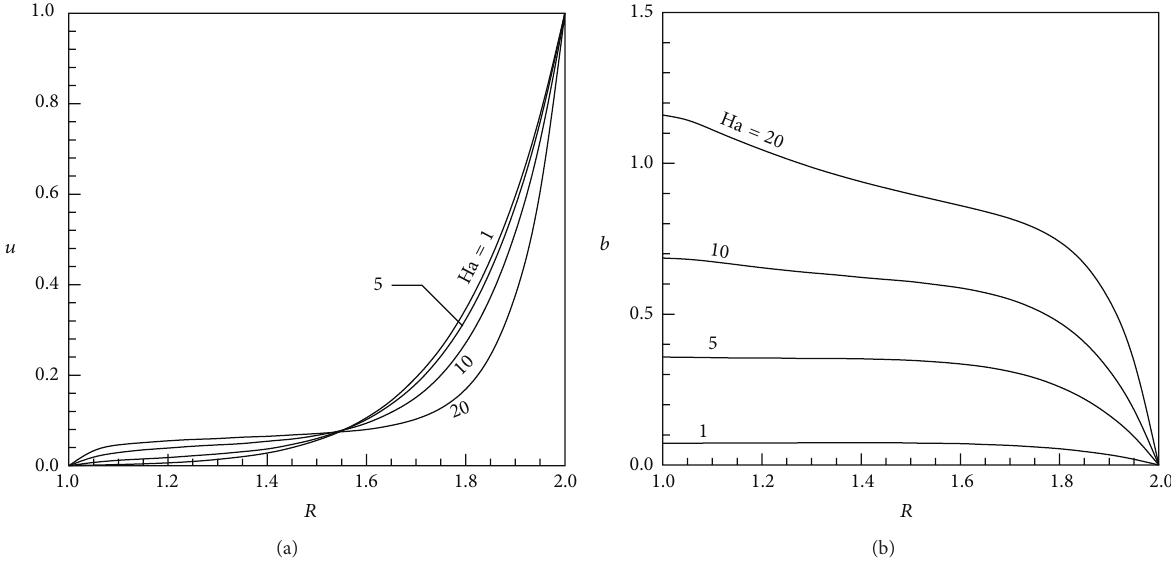
Figure7: Various profilesforDa =10 −2 anddifferent values ofHa when theoutercylinder isperfectly insulated whiletheinneroneisperfectly conducting: (a) velocity and (b) induced magnetic